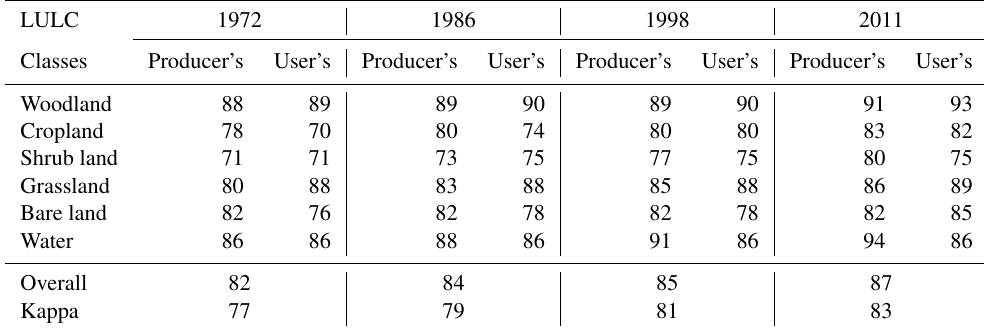
Table 3. Accuracy assessment (%) of LULC maps. LULC 1972